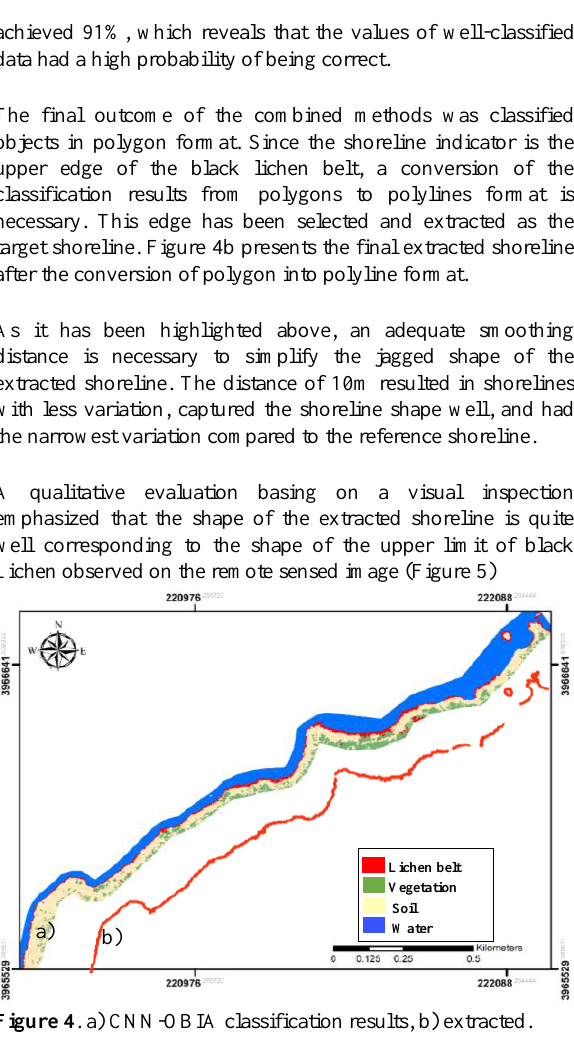
Figure 3 . Integrated CNN and OBIA method